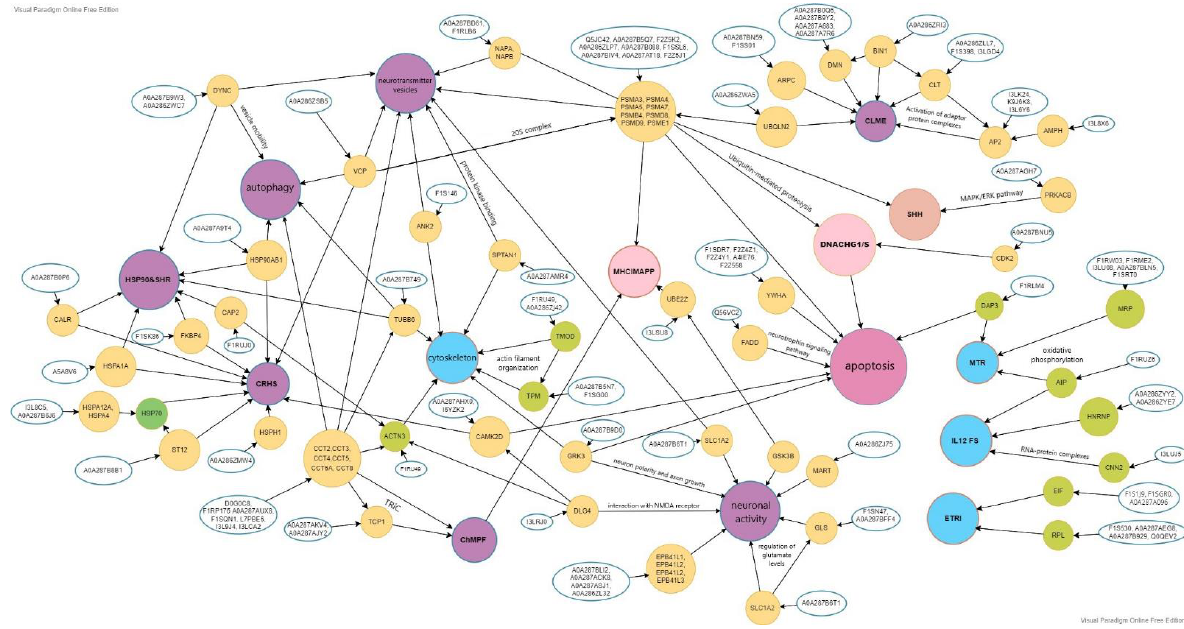
Figure 6. Unique proteins identified for the cerebral hemispheres of convalescent pigs according